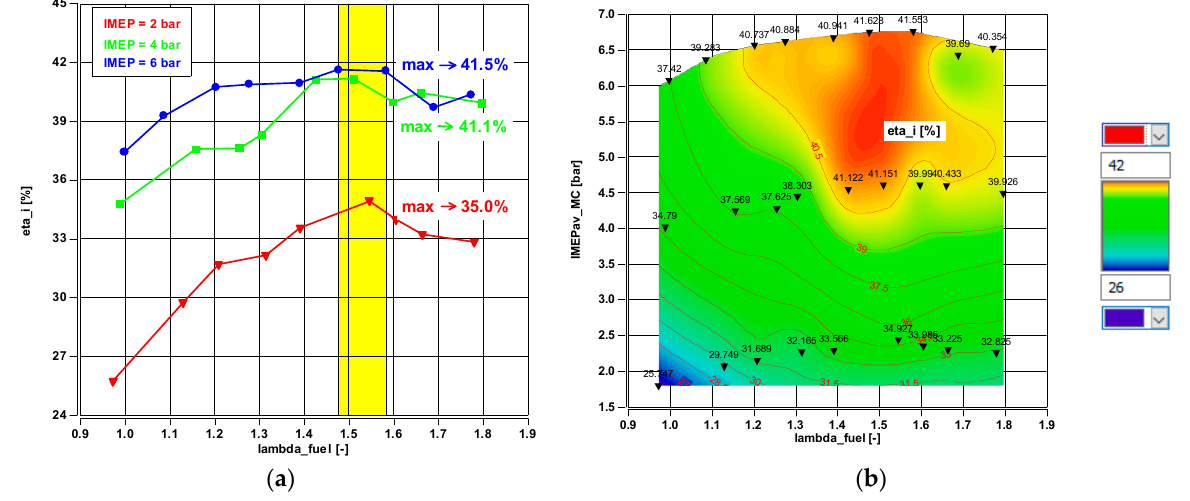
Figure 18. Evaluation of engine indicated efficiency: ( a ) as a function of mixture composition; ( b ) as a map of load characteristics and excess air coefficient.